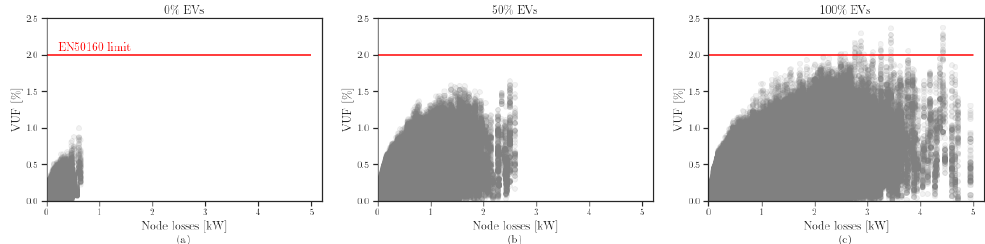
Figure 7. Voltage unbalance as a function of the node losses for various EV penetrations without PV systems, with: ( a ) 0% EV penetration; ( b ) 50% EV penetration; ( c ) 100% EV